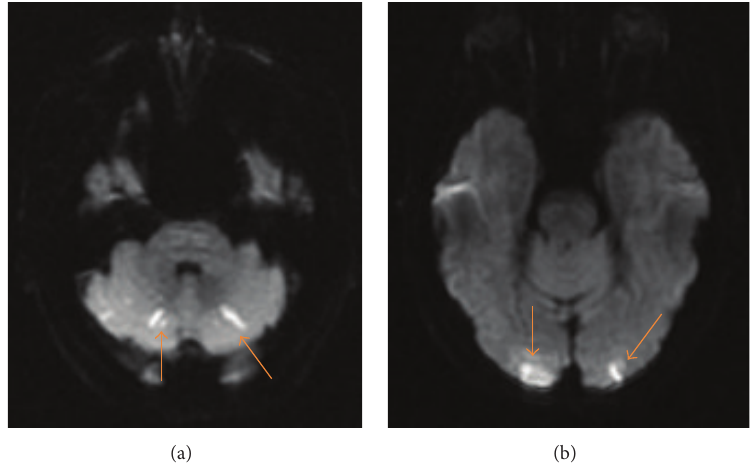
Figure 1: Acute ischemic infarct, MRI brain DWI sequences. (a) Bilateral cerebellum. (b) Bilateral occipital lobes.